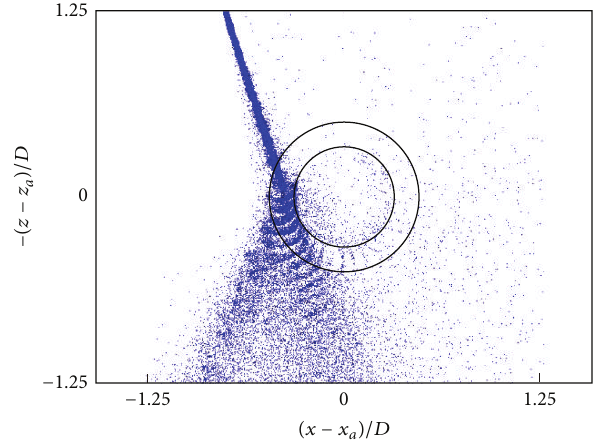
Figure 12: Distribution of superimposed particles when 𝜆 = 0.7